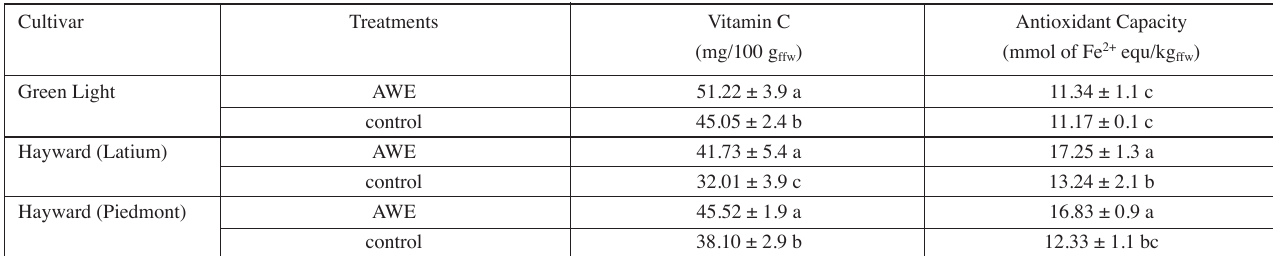
Tab. 3: Nutraceutical parameters in cv. Green Light and cv. Hayward: mean values in each row for the same parameter followed by different letters are signi- ficantly different as determined by Tukey’s HSD test following ANOVA ( p ≤ 0.05). Cultivar